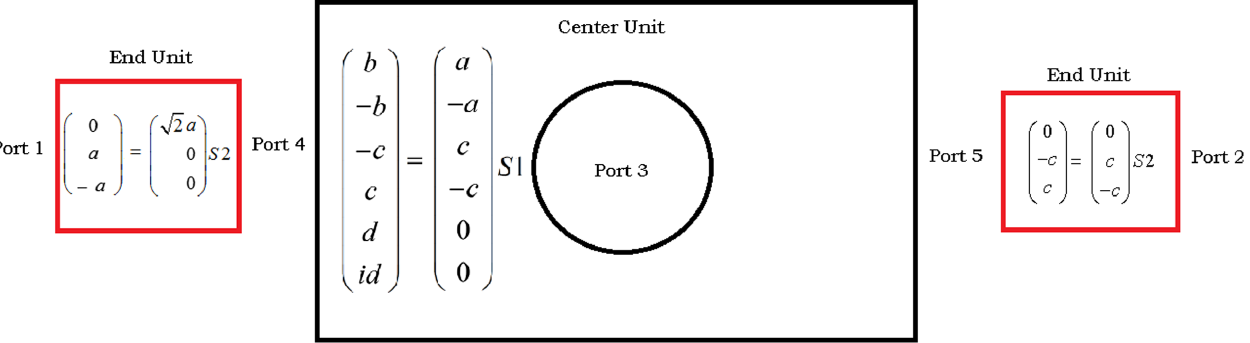
FIG. 4. The schematic matrix cascading at a steady state of the whole transducer system. The input and output of the center unit and end unit are 6-elements vectors and 3-elements vectors, respectively.